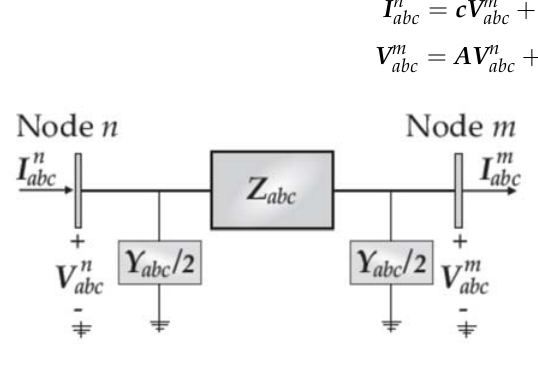
Figure 1. Distribution line segment (series component).